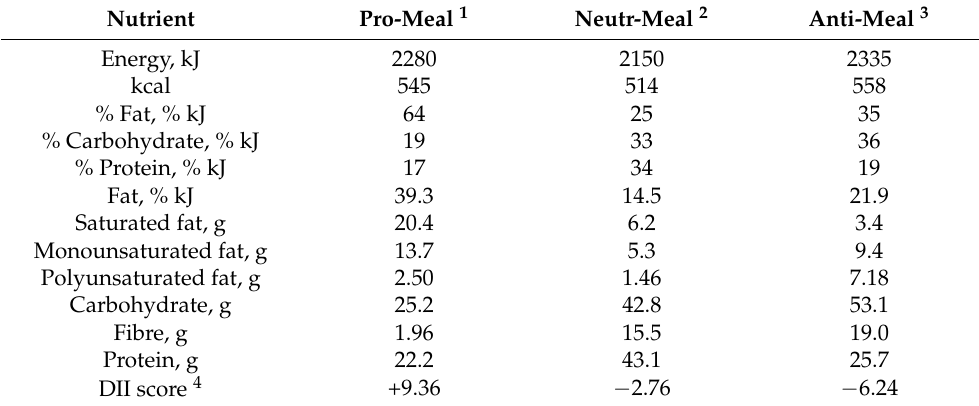
Table 1. Meal composition and dietary inflammatory index scores. Nutrient Pro-Meal